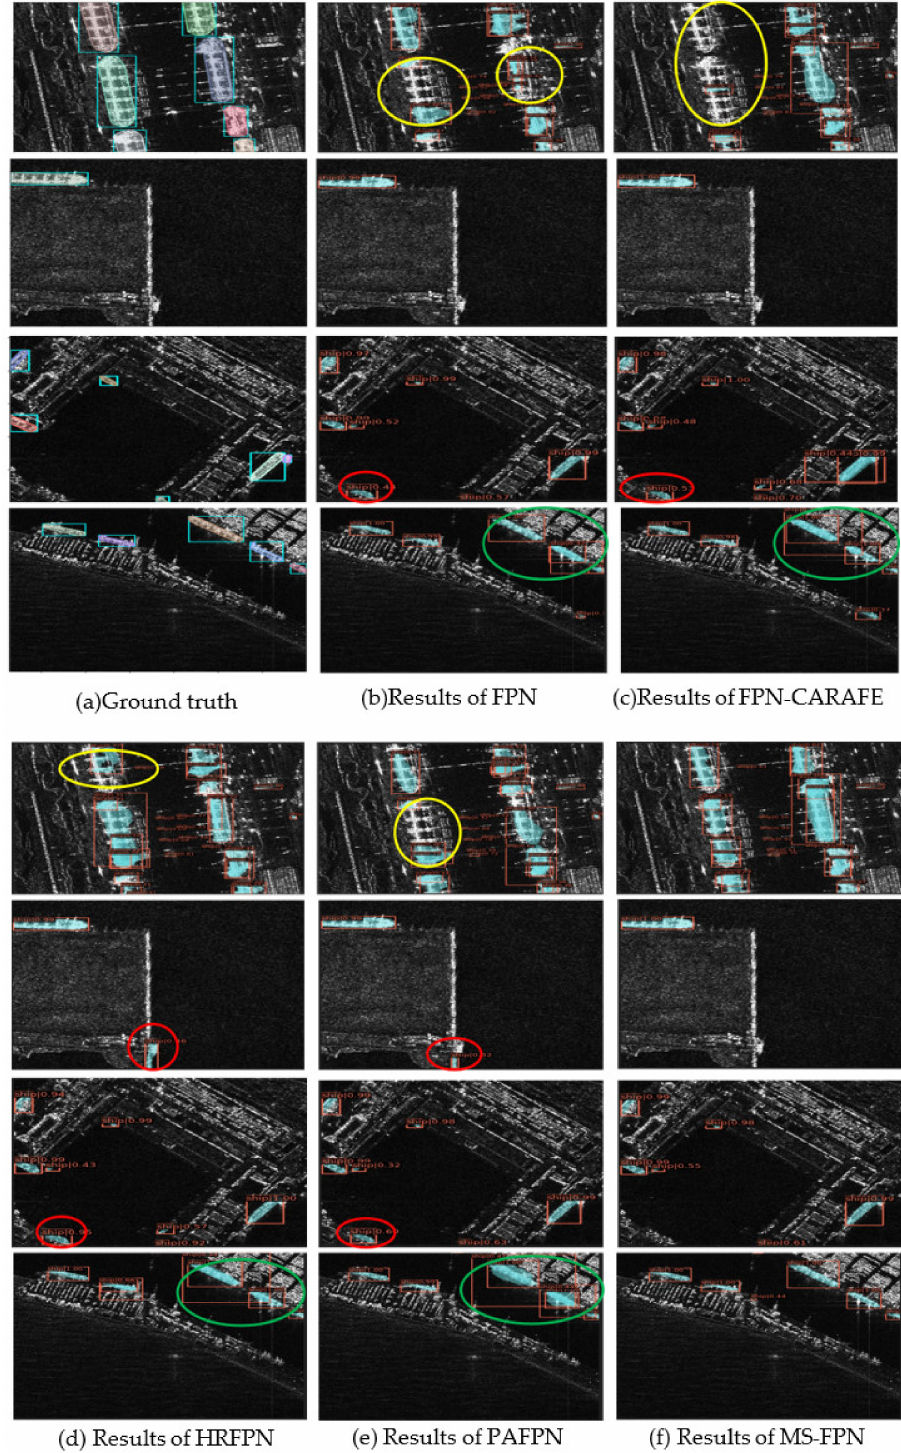
Figure 12. Comparison of FPN, FPN-CARAFE, HRFPN, and MS-FPN. ( a ) Ground truth. ( b – f ) Results of FPN, FPN-CARAFE, HRFPN, PAFPN, and MS-FPN, respectively. Red circles indicate false detections. Yellow circles indicate missed detections. Green circles indicate poor